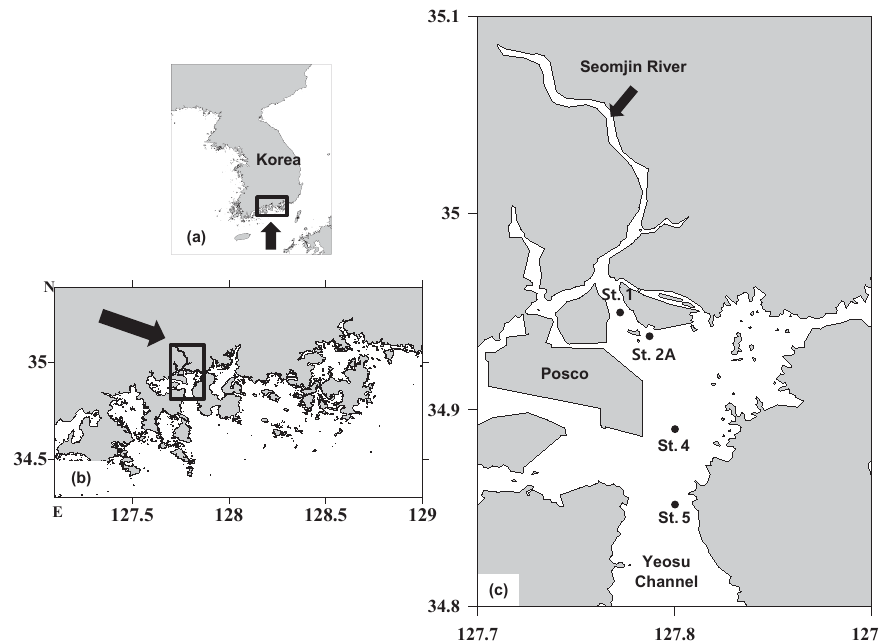
Figure 1. The sampling location in Gwangyang Bay, Korea. Maps of Korea (a) , the southern coastal sea (b) , and the main sampling sta- tions (c)